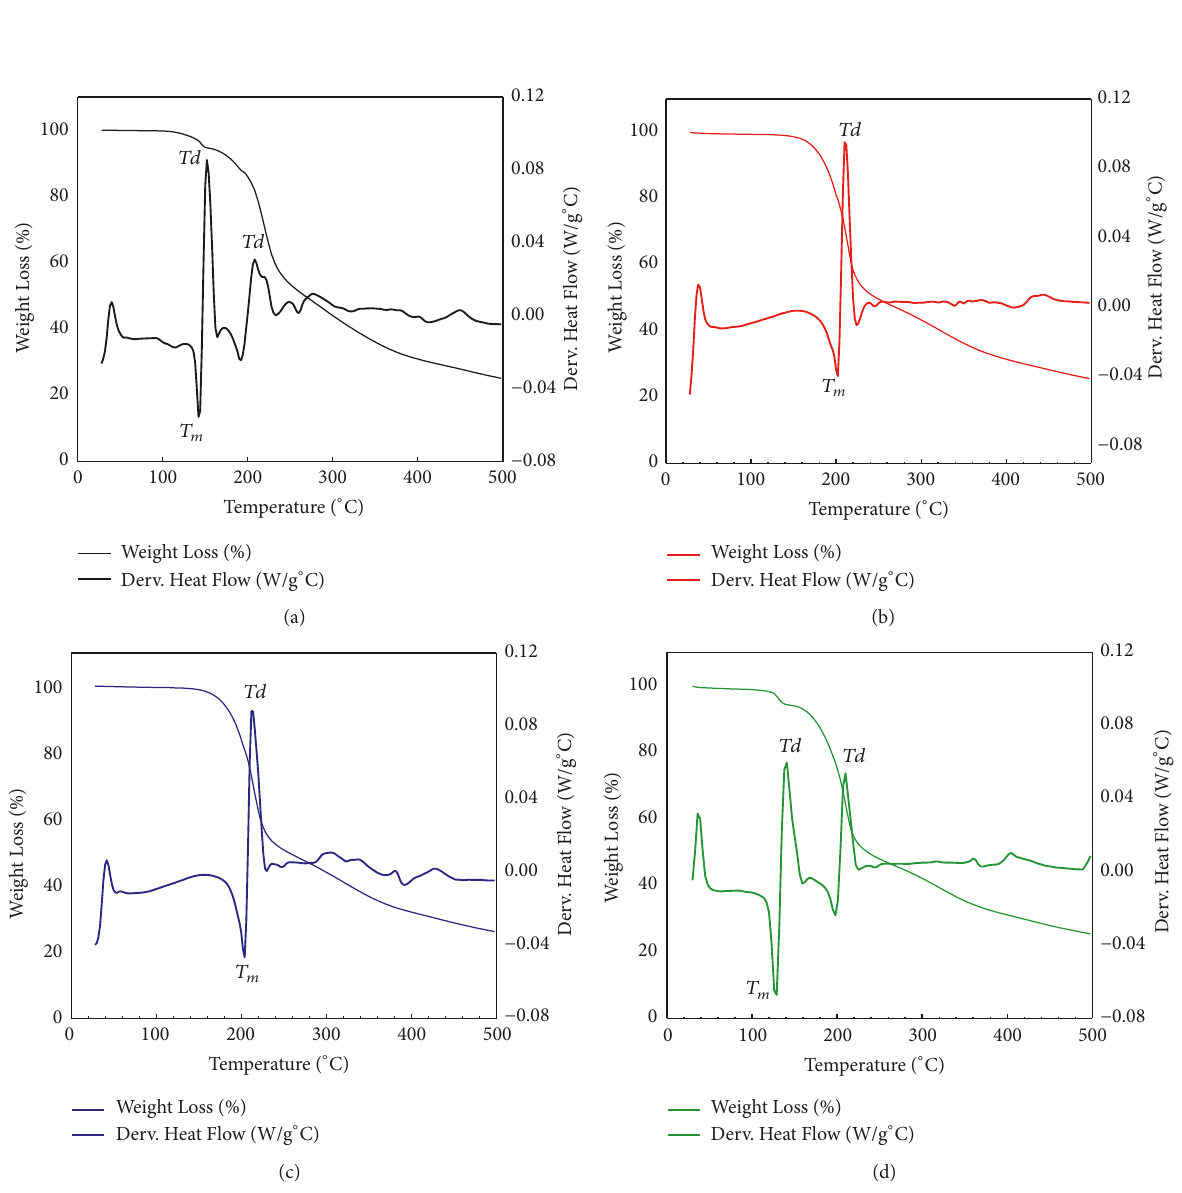
Figure 5: Simultaneous TGA-DSC of the samples synthesized at (a) 27, (b) 29, (c) 31, and (d) 32 ∘